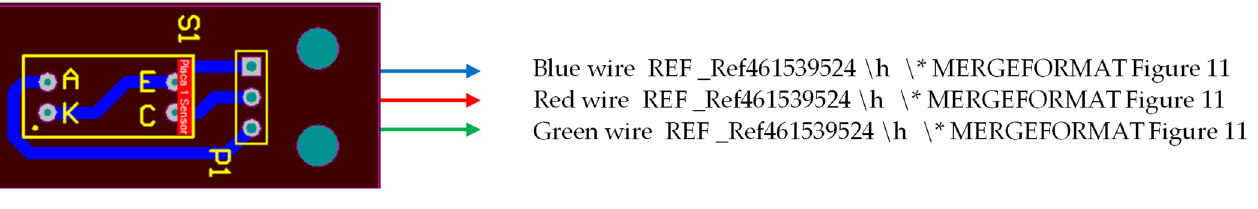
Figure 16. PCB design of an optical sensor board (bottom layer).